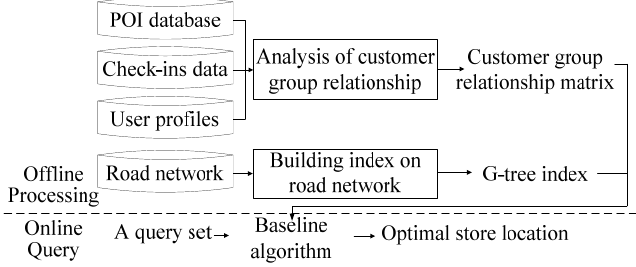
Figure 2. System framework of the baseline algorithm.